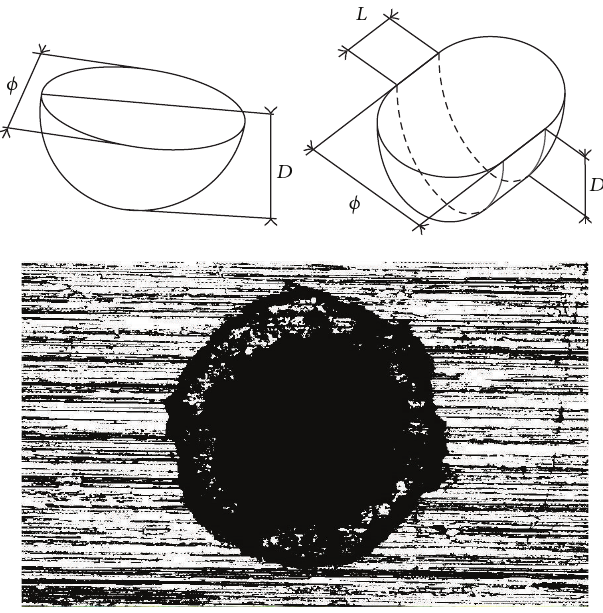
Figure 1: Cavity geometries used in the